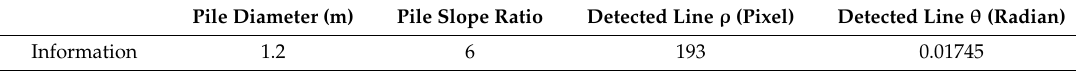
Table 4. Pile and detected line parameters.